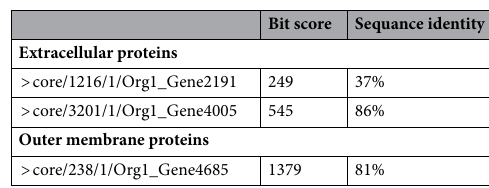
Table 2. Virulent proteins were identified in the set of exposed